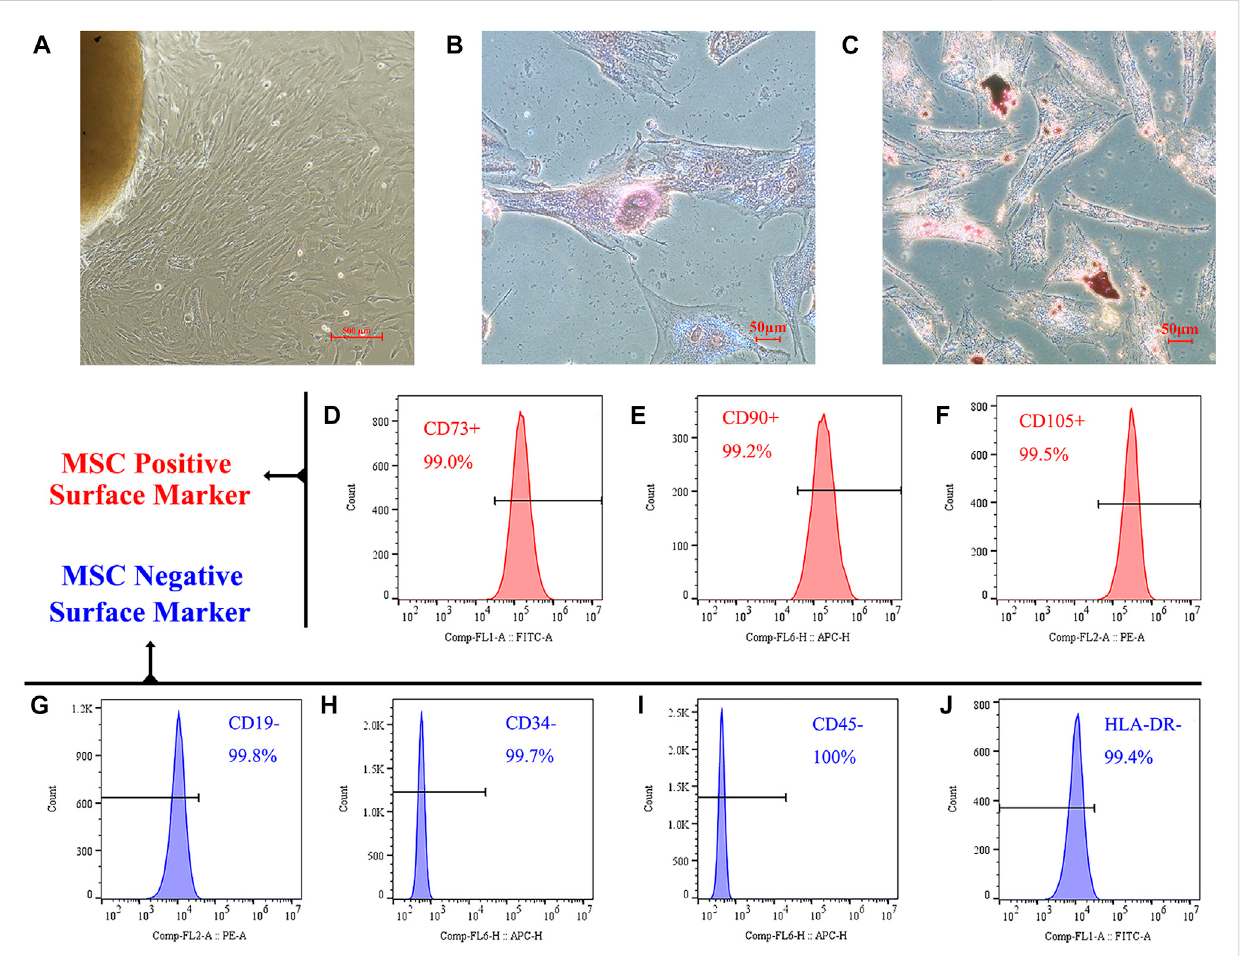
FIGURE 1 Identi fi cationofhucMSCs. (A) HucMSCswereisolatedandpuri fi edthroughtheirphysicaladherencetotheplasticcellcultureplate. (B) AlizarinredS staining demonstrated that mineralized nodules were formed in the hucMSCs 3 weeks after osteogenic induction. (C) Oil-red-O staining showed lipid- rich vacuole formation in the mouse BM-MSCs after 3 weeks of adipogenic induction. (D – F) Flow cytometry analysis showed that these cells were positiveforMSCmarkersCD73 (D) ,CD90 (E) ,andCD105 (F) . (G – J) CellswerenegativeforBcellmarkerCD19 (G) ,endothelialcellmarkerCD34 (H) , pan-leukocyte marker CD45 (I) , and stimulated immune cell marker HLA-DR (J)